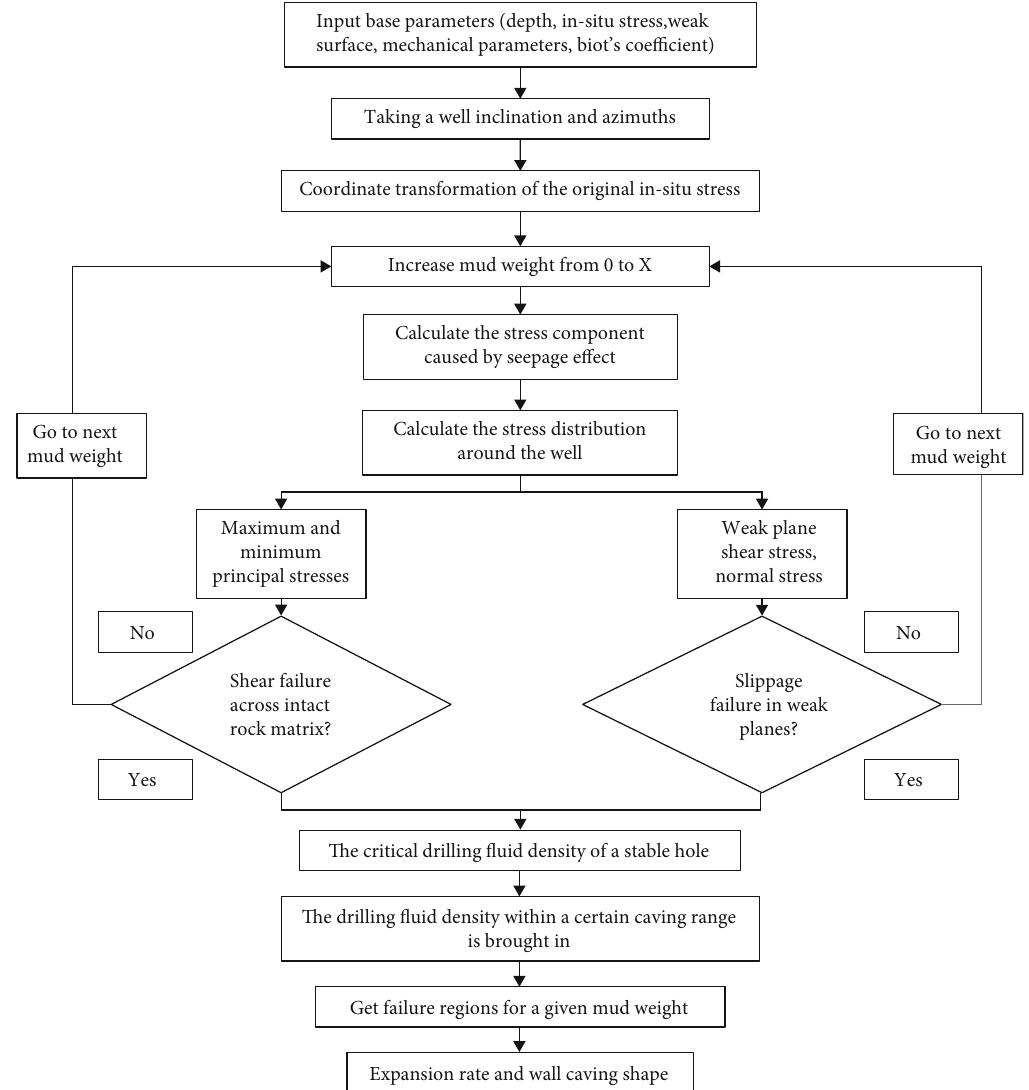
Figure 3: Flow chart of the borehole wall and surrounding instability area.